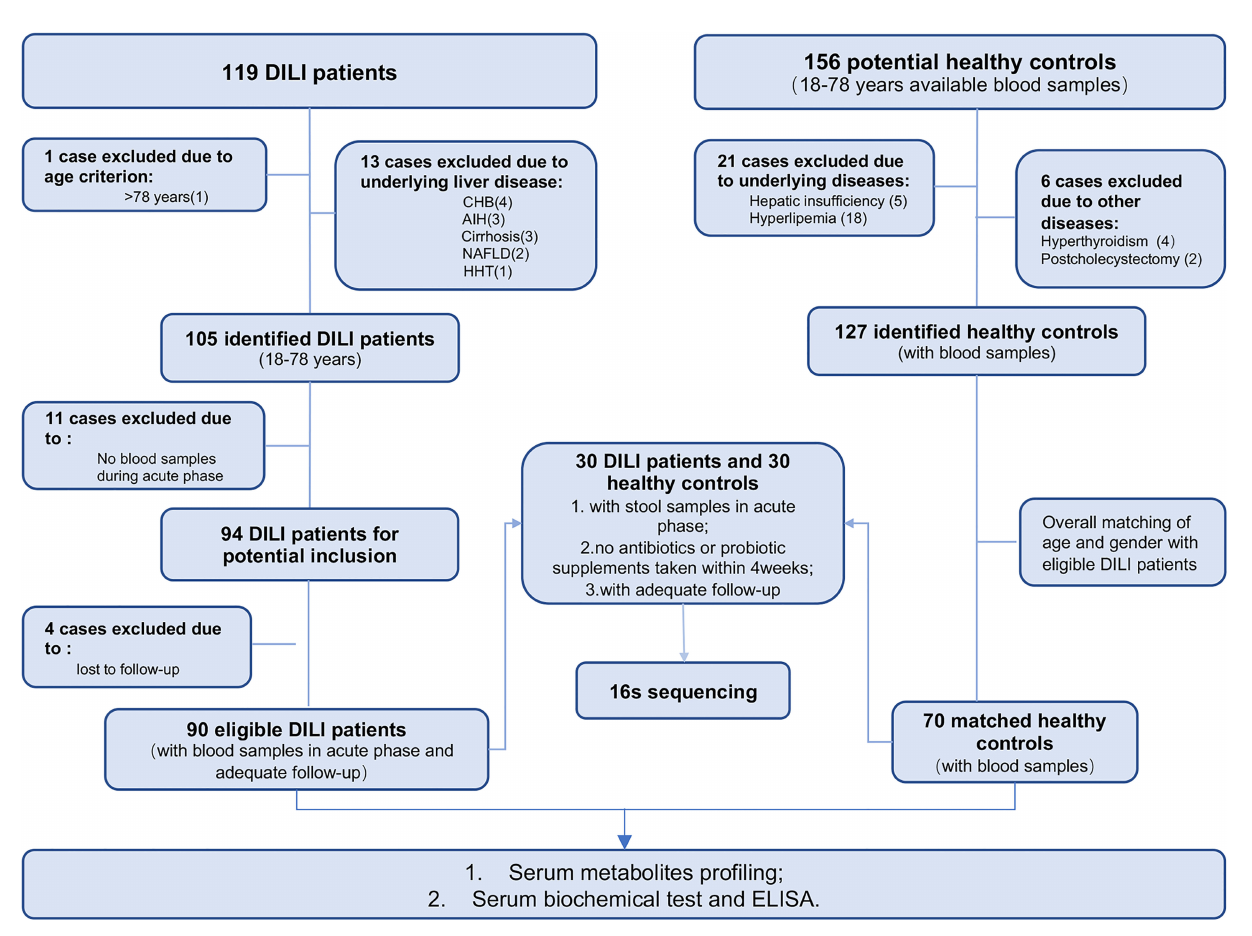
FIGURE 1 | Enrollment of DILI patients and healthy control subjects. CHB, chronic hepatitis B; AIH, autoimmune hepatitis; NAFLD, nonalcoholic fatty liver disease; HHT, hereditary hemorrhagic telangiectasia; MDA, malondialdehyde; GSH-Px, glutathione peroxidase; FGF19, fi broblast growth factor 19. (Created with